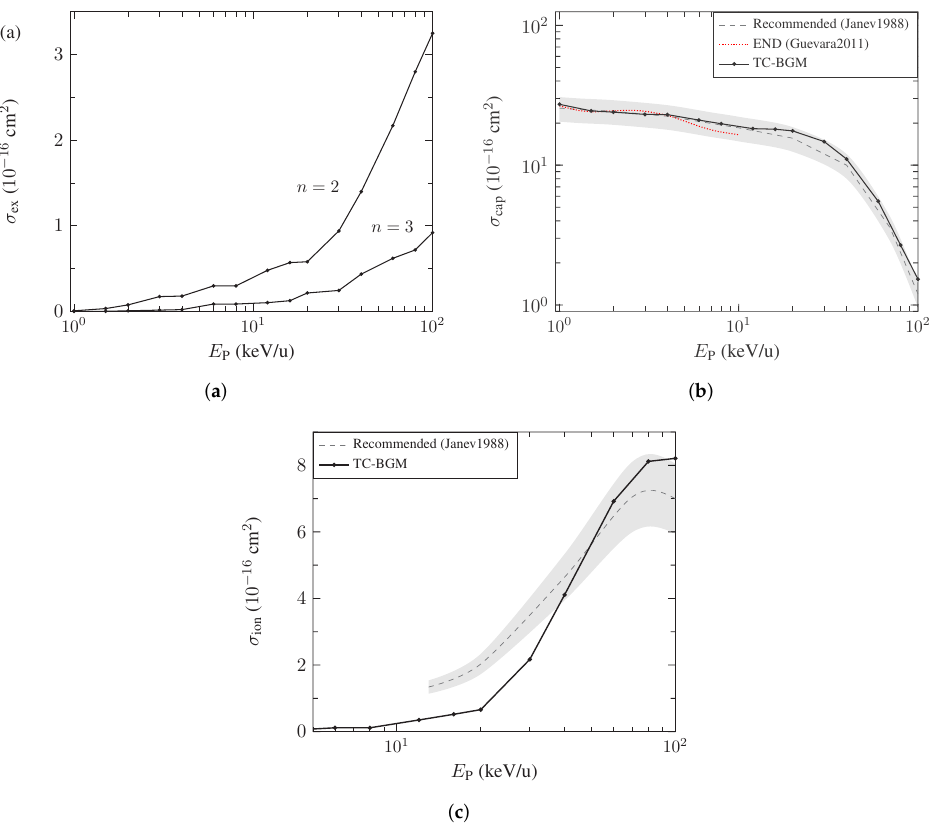
Figure 4. Cross sections for O 3 + -H collisions from 1 to 100 keV/u: ( a ) target excitation; ( b ) electron capture; ( c ) ionization. Recommended data from Ref. [8]. Theory: present TC-BGM and END